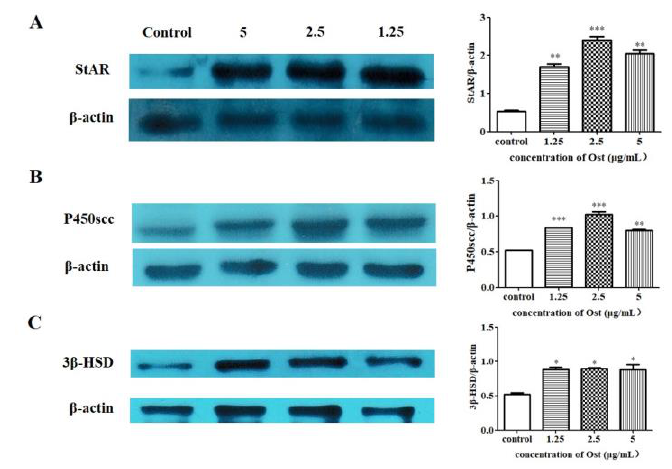
Figure 7. Western blot analysis of StAR ( A ), P450scc ( B ), and 3β-HSD ( C ) protein expression in granulosa cells after treatment with Ost (5, 2.5, 1.25 μg/mL) for 24 h. Image J software was used to analyze gray scales of Western blot images. Data were expressed as Mean ± SEM. * p < 0.05, ** p < 0.01, *** p < 0.001.